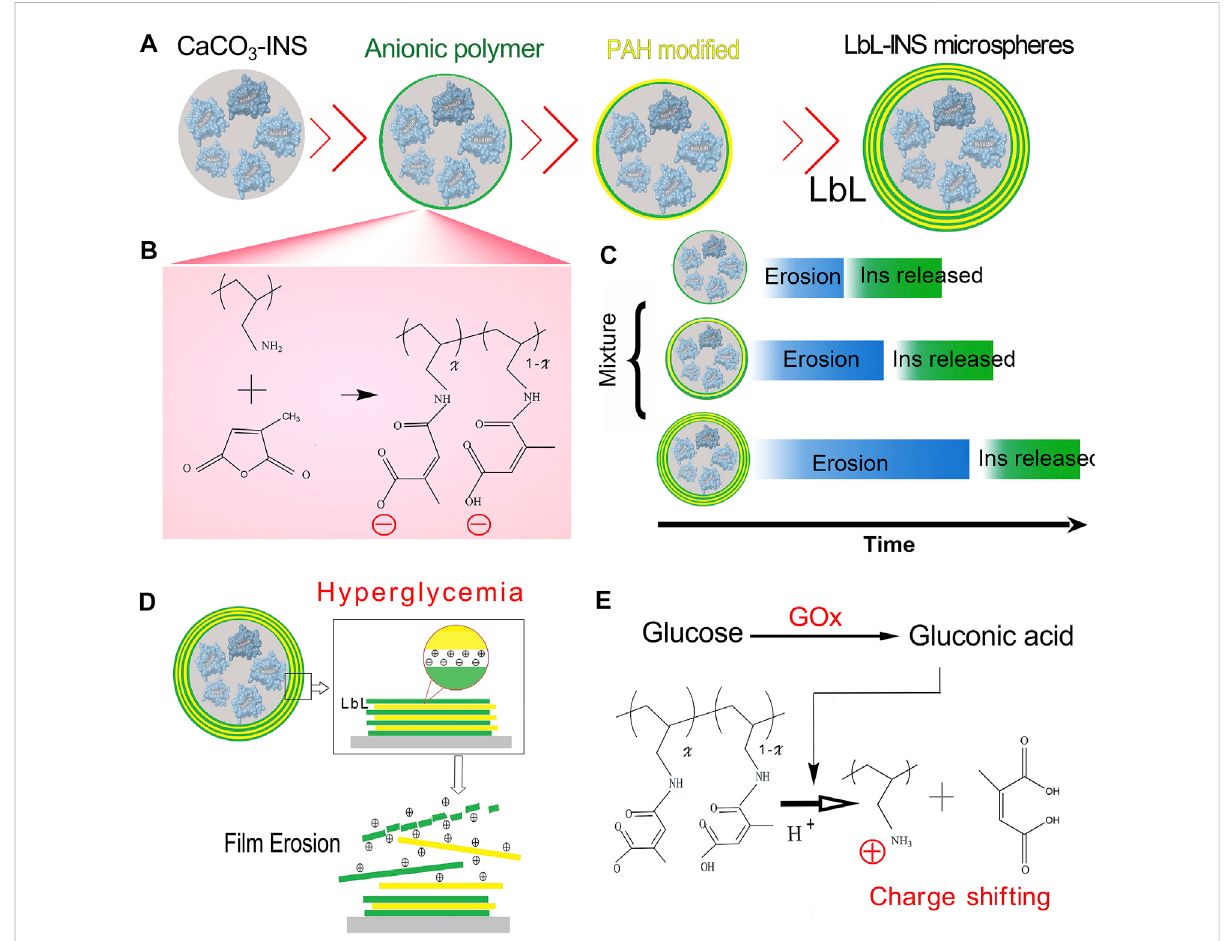
FIGURE 1 Scheme of the mixed multiple layer-by-layer insulin (mmLbL-INS) microcapsules. (A) Synthesis of the multiple LbL-INS microcapsules. The anionic polymer was regarded stable in physiologically relevant environments and hydrolysis of the charge-shifting anionic polymer under acidic conditions yields a cationic polymer. Based on the LbL assembly of multilayered polyelectrolyte fi lms, with repeat assembly sequences polycation PAH and anionic polymer, we fabricated LbL-INS microspheres with different layers. (B) Synthesis of degradable anionic polymers. (C) Schematic of mmLbL-INS microcapsules controlling the INS release time. (D) In hyperglycemia, glucose-activated changes in the net charge of the polymer led to changes in the nature of ionic interactions inthe multilayers and promoted fi lm disruption. (E) Hydrolysis of the citraconic amide side chains of the charge-shifting anionic polymer under acidic